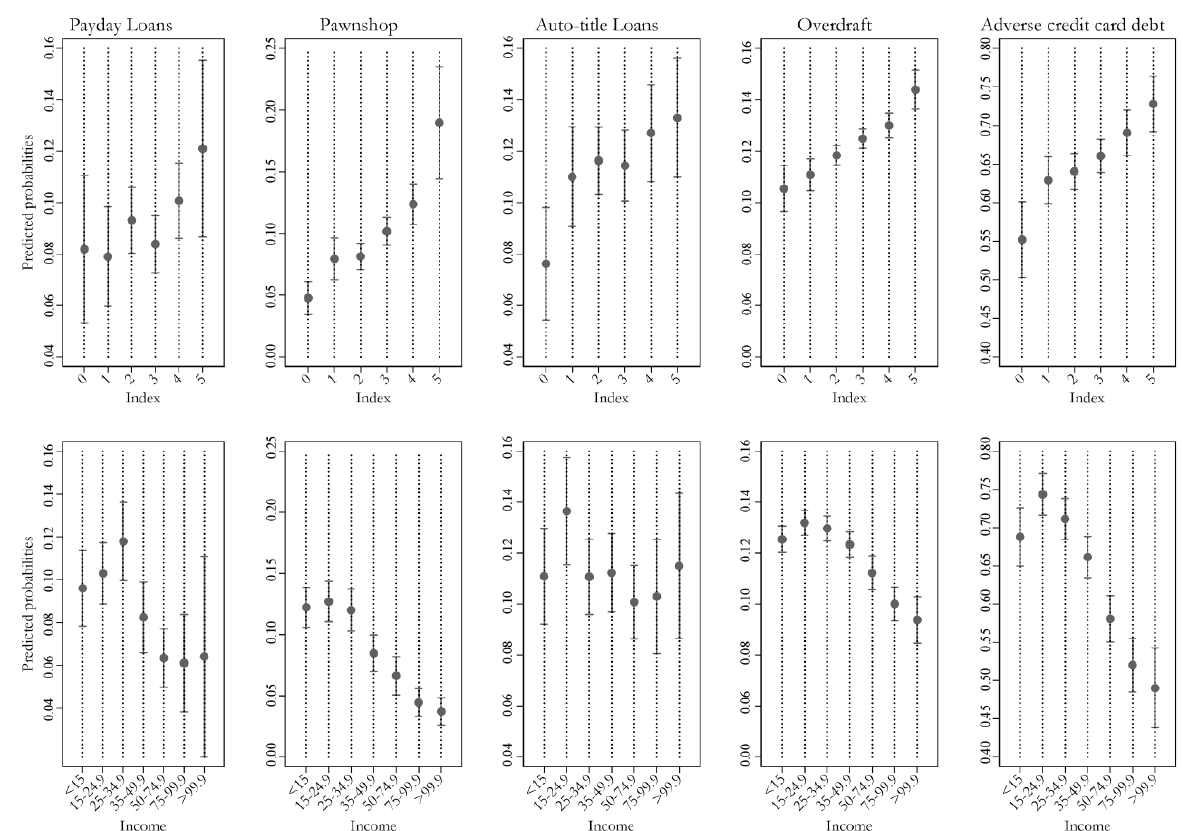
Figure 1: Predicted probabilities by schedule unpredictability index and household income (weighted). Notes: Models include all controls and use robust standard errors. Sample for auto-title loans conditional on having a car. Sample for overdraft conditional on being banked. Sample for adverse credit card debt conditional on having a credit